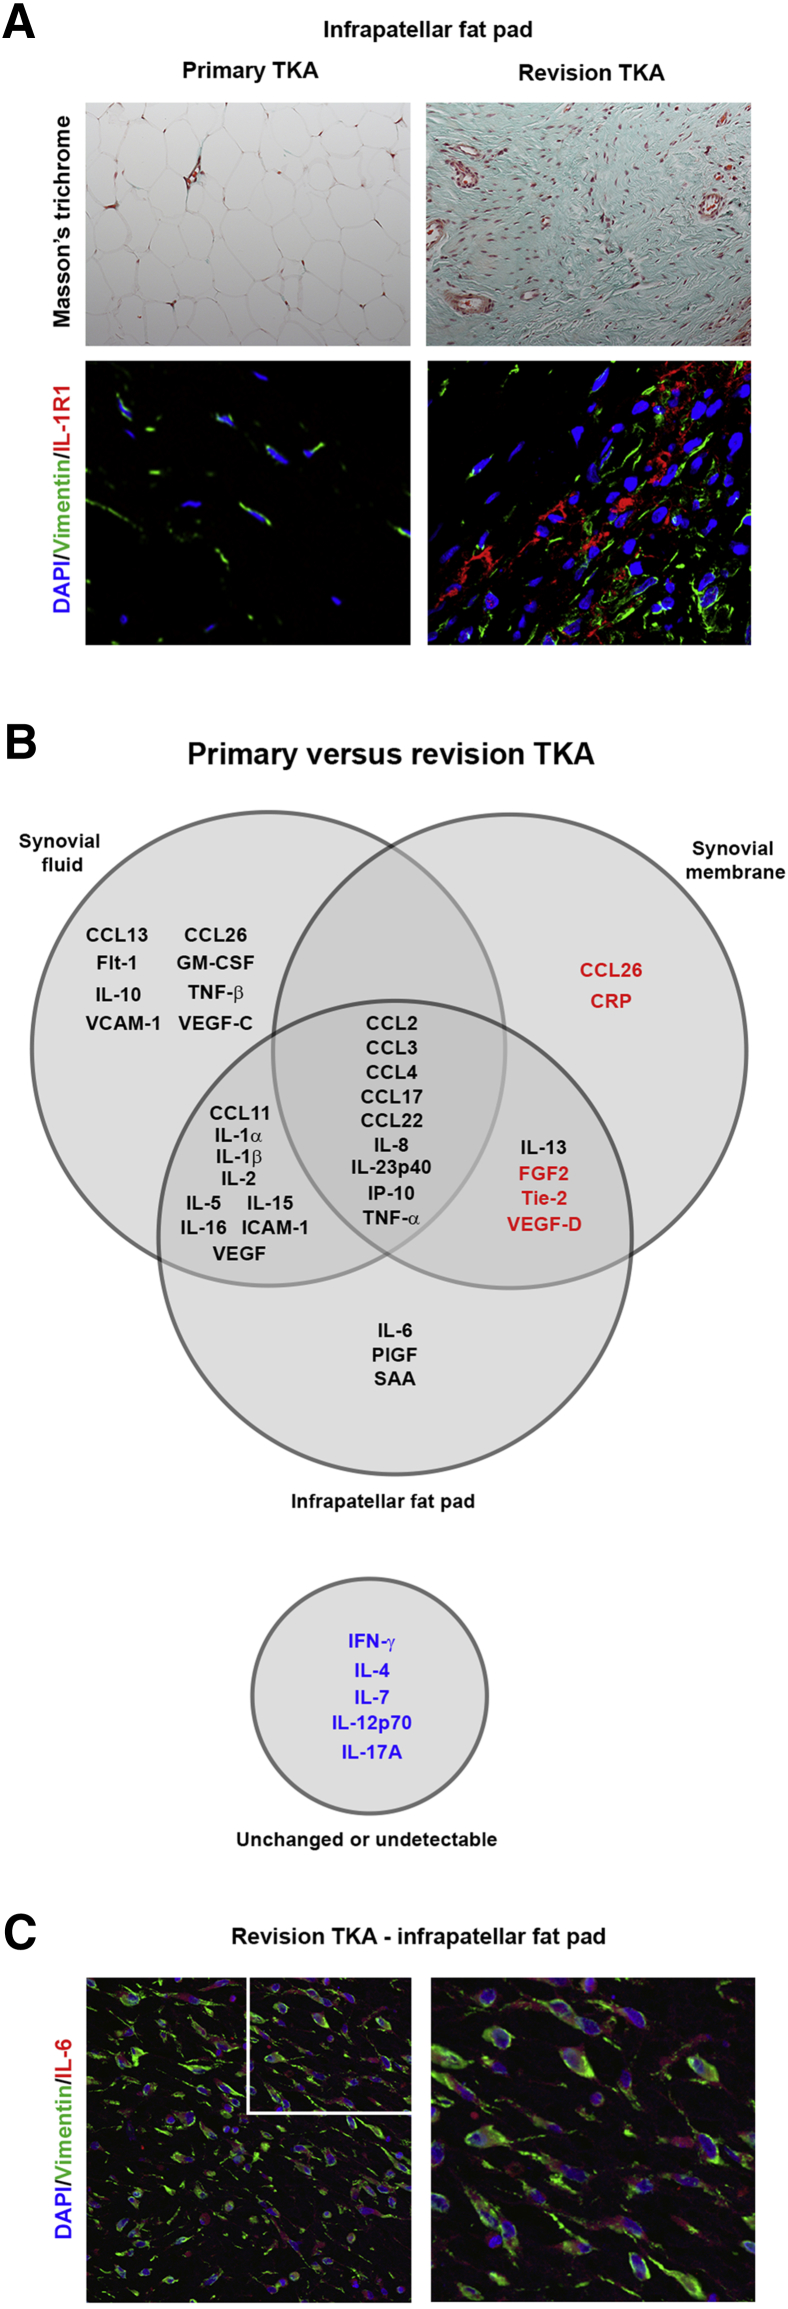
Synovial fluid and tissues isolated from patients undergoing revision total knee arthroplasty (TKA) are characterized by dramatic tissue remodeling and chronic inflammation. A: Representative images of Masson trichrome and IL-1R1 (green [fluorescein isothiocyanate (FITC)])/vimentin (red [tetrarhodamine isothiocyanate (TRITC)]) stained infrapatellar fat pad from patients undergoing primary TKA and patients undergoing revision TKA. There is a significant increase in collagen and IL-1R1 expression in revision TKA tissue compared with primary TKA tissue, and IL-1R1 is predominantly expressed on elongated bipolar mesenchymal cells in revision TKA tissue. Images acquired on a Nikon inverted microscope and a Nikon A1R point scanning confocal microscope, respectively. B: Venn diagram demonstrating change in protein expression in synovial fluid, infrapatellar fat pad, and synovial membrane isolated from patients undergoing revision TKA compared with patients undergoing primary TKA. Protein expression was quantified using human V-Plex electrochemiluminescence detection kits from MesoScaleDiscovery. Markers in black text are significantly elevated in revision TKA, markers in blue text are not significantly different or undetectable, and markers in red text are significantly decreased in revision TKA. Significance was taken as P < 0.05. C: Representative images of vimentin [green (FITC)]– and IL-6 [red (TRITC)]–stained infrapatellar fat pad from patients undergoing revision TKA. There are a significant number of vimentin and IL-6 dual-positive fibroblasts in post-TKA infrapatellar fat pad. Images acquired on a Nikon A1R point scanning confocal microscope. Original magnification, ×20 (A and C); ×40 (inset). CRP, C-reactive protein; FGF, fibroblast growth factor; Flt, Fms-like tyrosine kinase 1; GM-CSF, granulocyte-macrophage colony-stimulating factor; ICAM, intercellular adhesion molecule; IFN, interferon; IP-10, interferon gamma-induced protein 10; PIGF, placental growth factor; SAA, serum amyloid A; Tie, tyrosine kinase; TNF, tumor necrosis factor; VCAM, vascular cell adhesion molecule; VEGF, vascular endothelial growth factor.